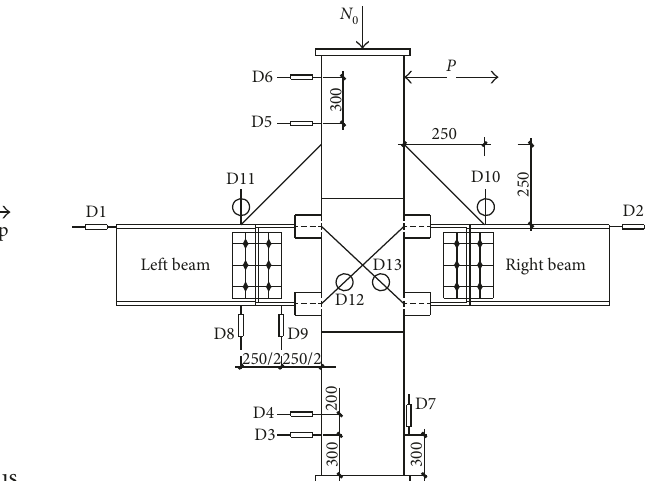
Figure 7: Arrangement of the deformation